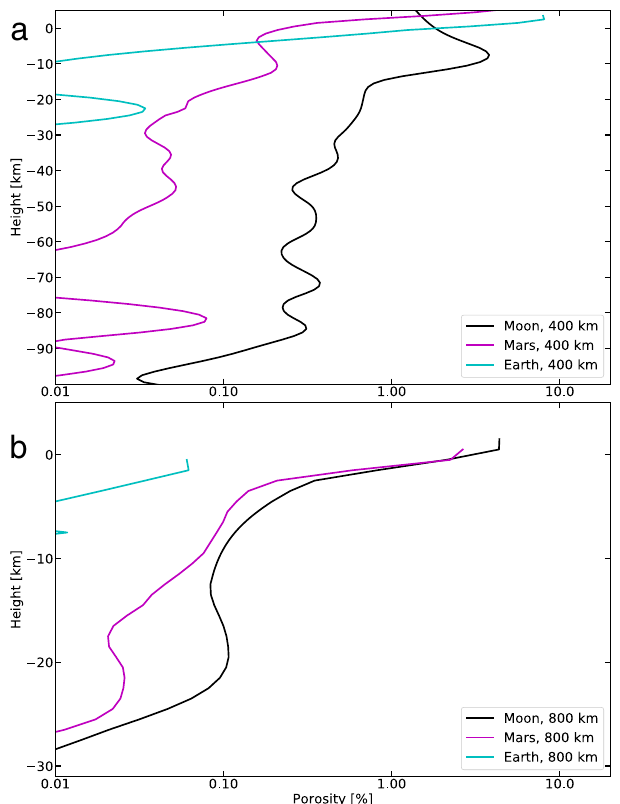
Fig.4|Porositypro fi lesonMoon,Mars,andEarthafterlargeimpacts. Porosity pro fi les at 400 ( a ) and 800 ( b ) km away from the point of contact of a 100km diameter impactor striking surfaces under lunar (black), martian (magenta), and Earth (cyan) gravities. Each pro fi le is horizontally averaged over 11 cells centered around 400km and